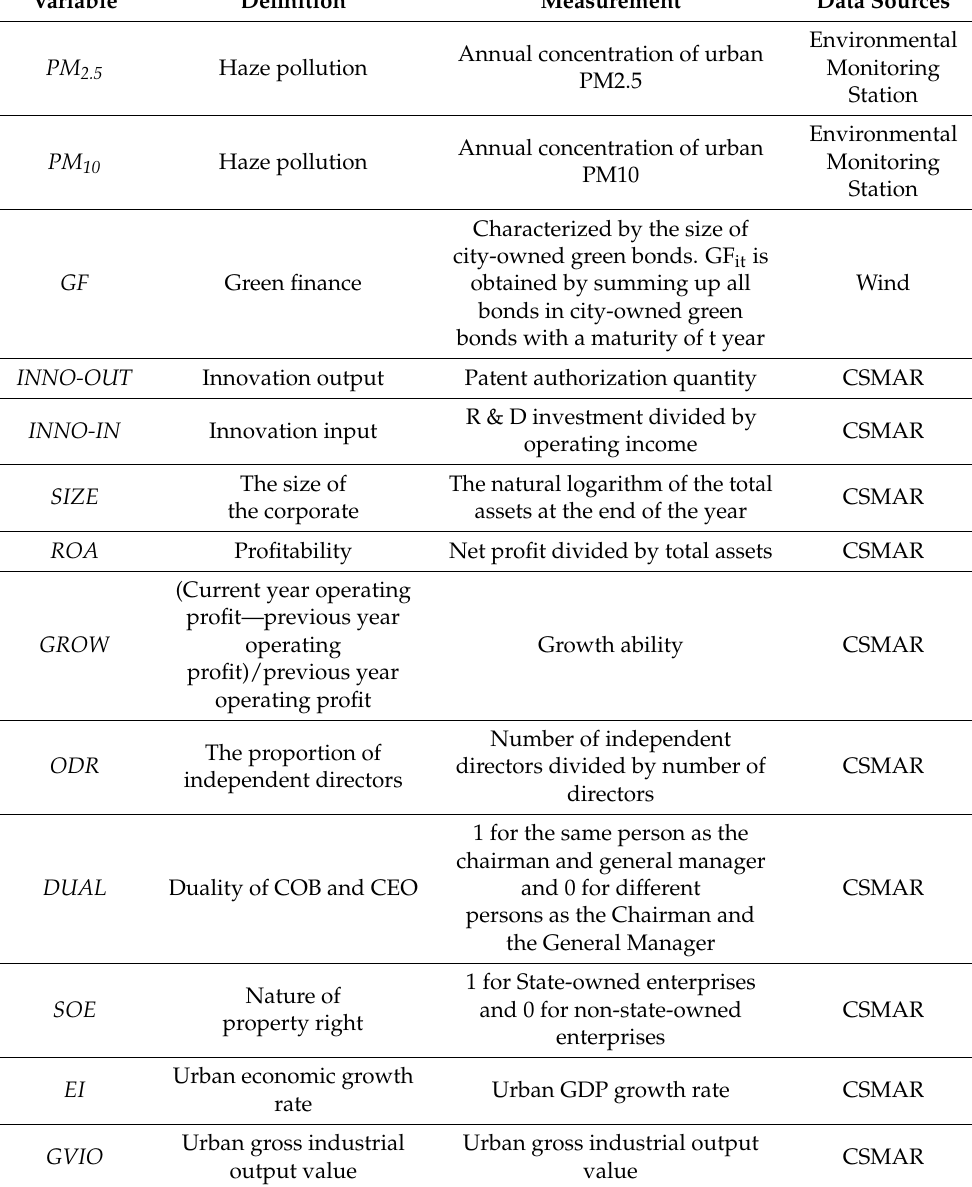
Table 1. Variable definitions and data